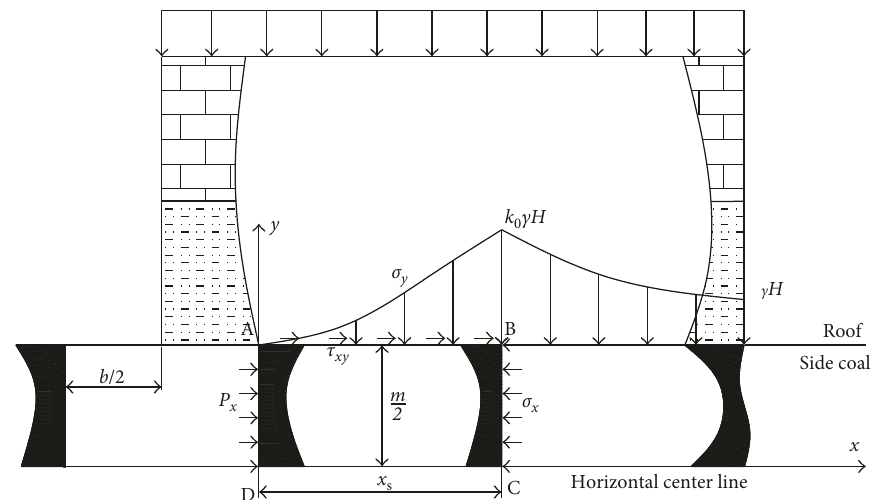
Figure 1: Mechanical